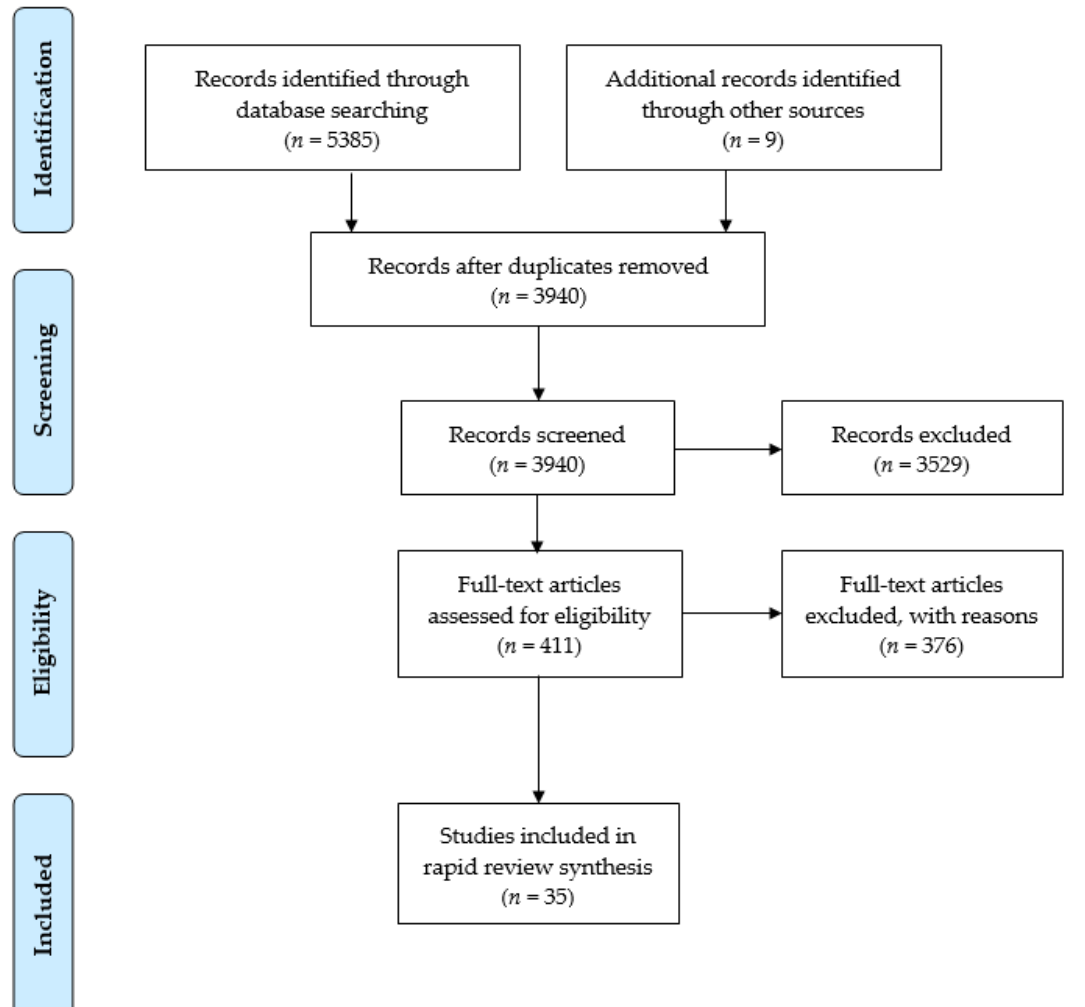
Figure 2. The preferred reporting items for systematic reviews and meta-analysis for RQ2. Adapted from